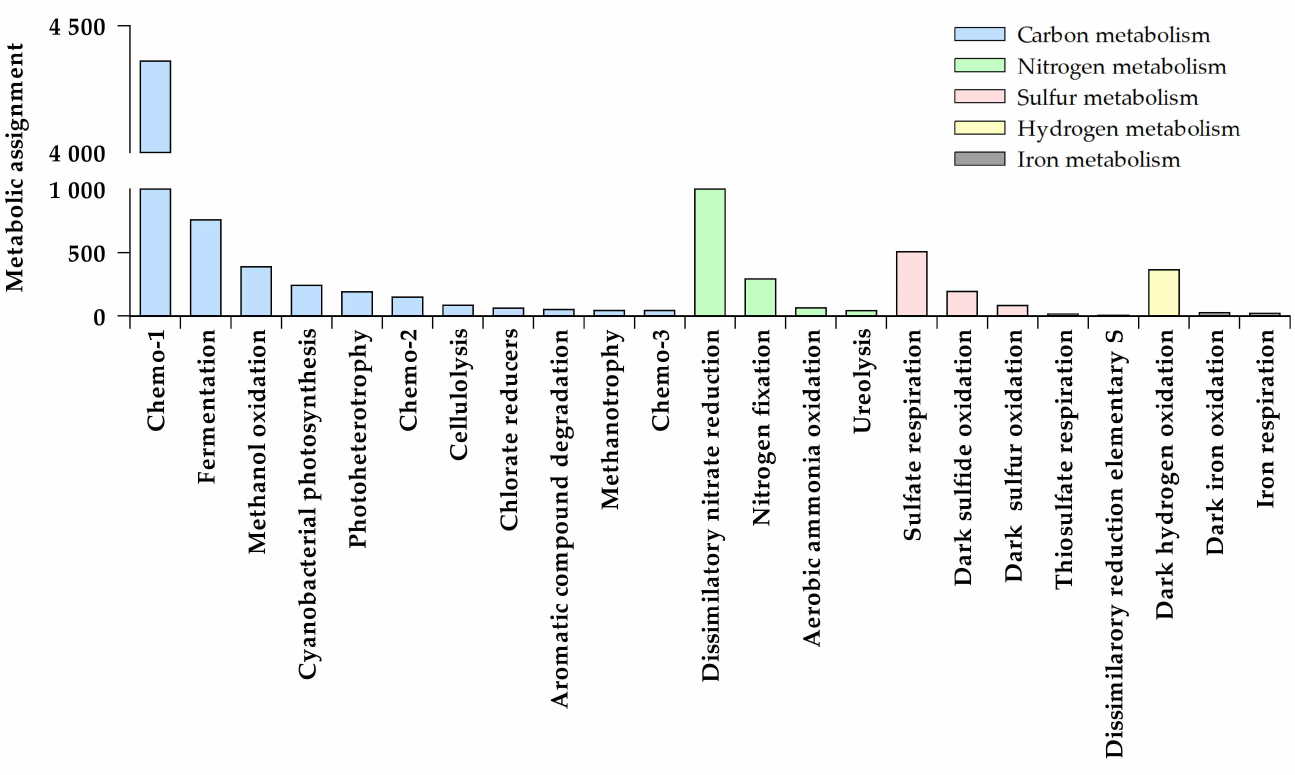
Figure 1. Abundance (metabolic assignments, number of associated reads) of the main metabolisms associated with the biogeochemical cycles of carbon, nitrogen, sulfur, hydrogen, and iron found in the whole set of lake